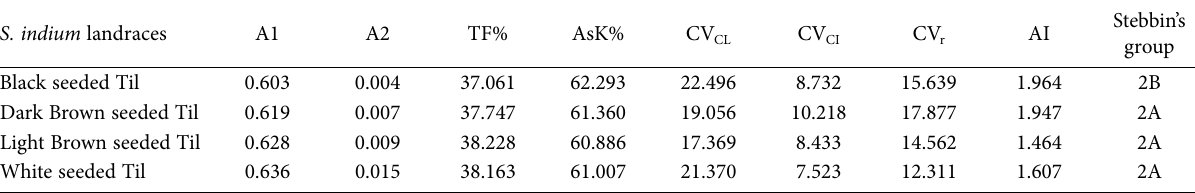
Table 2. Comparative karyometric analysis of four Indian landraces of S. indicum *.